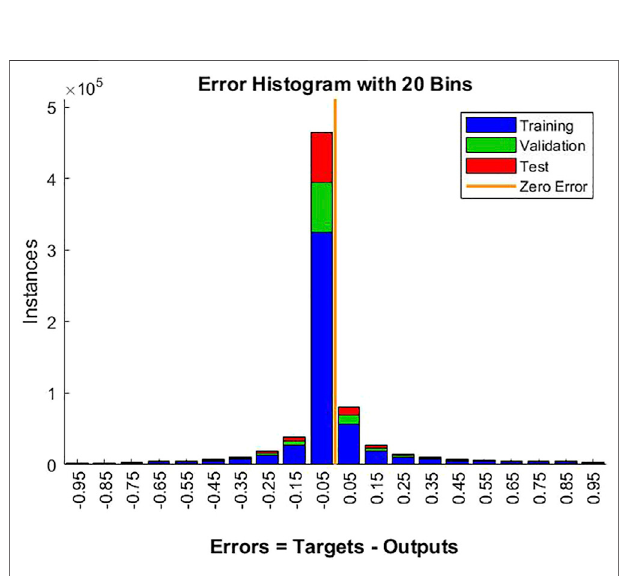
FIGURE 9 | Error histogram with maximum classi fi cation